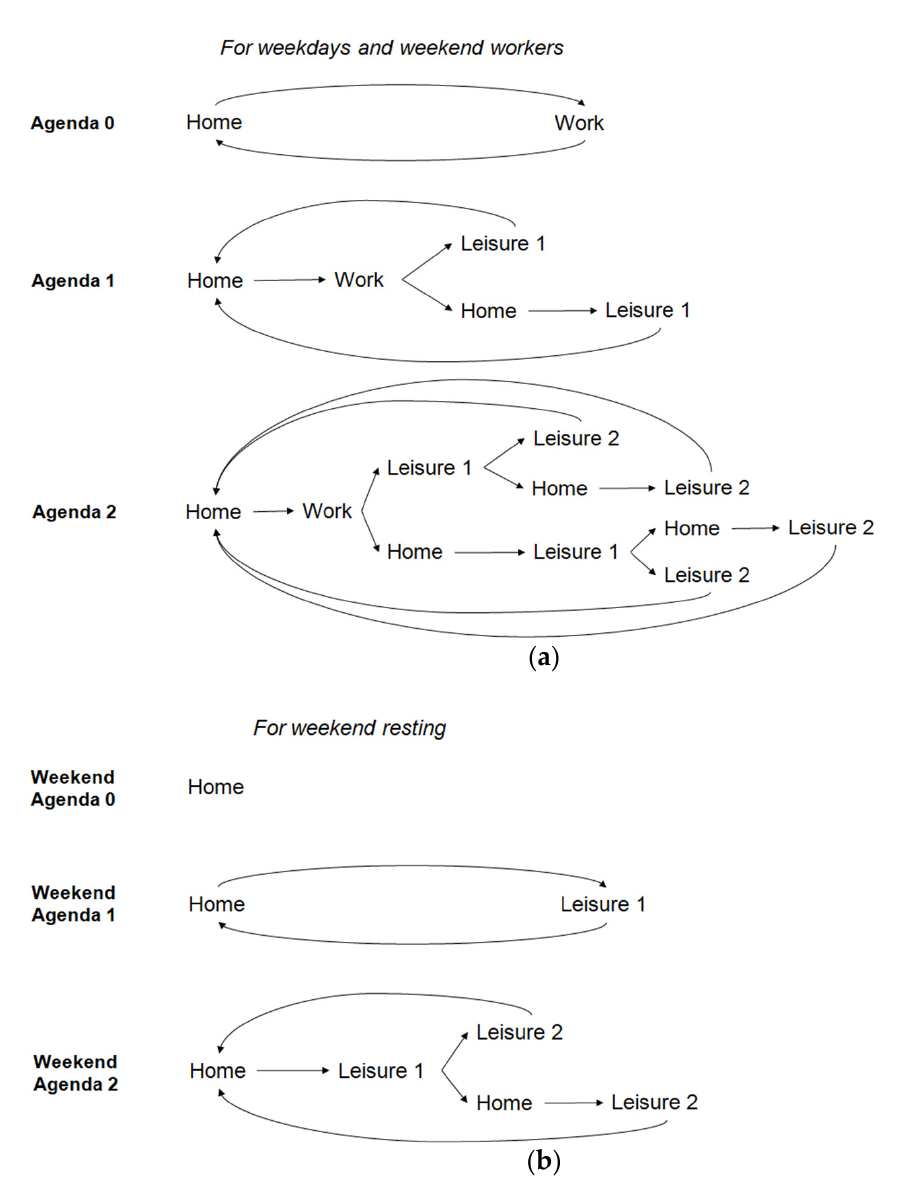
Figure 1. The different implemented daily agendas for the people agents in the simulation for ( a ) weekdays, including the weekend workers who have similar behaviour to the one they have on weekdays and ( b ) weekends for all people agents that do not work on weekends.